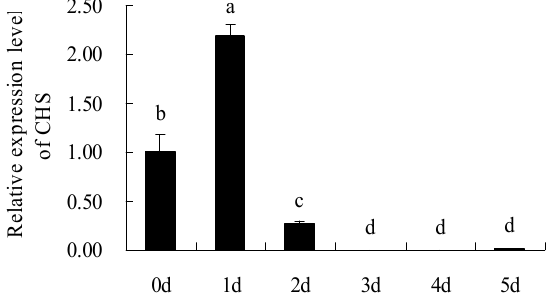
Figure 6. Expression patterns of BaCHS transcripts in the petals at sequential stages of flower opening over 6 days of Brunfelsia acuminata . Abundances were determined by comparison with an internal reference ( BaActin ) and are shown relative to the expression level on Day 0, which was given a value of 1. The data represent means ± SD of three replicate ( n = 3). Where no error bars are present, The SD was smaller than the size of the symbol. Different letters indicate significant differences ( p < 0.05).